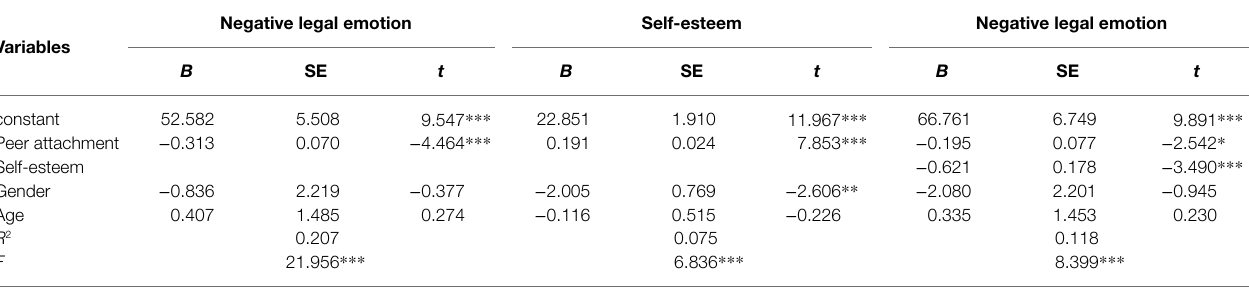
TABLE 4 | Results of multiple regression analyses.